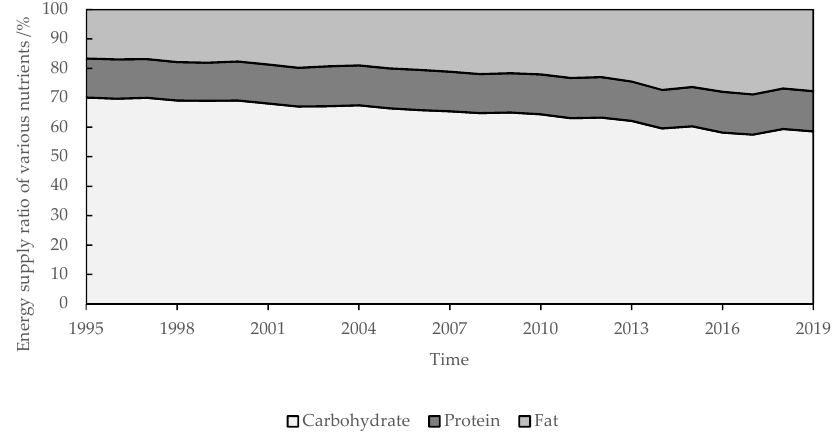
Figure 2. Per capital-nutrient intake in the QTP from 1995 to 2019.